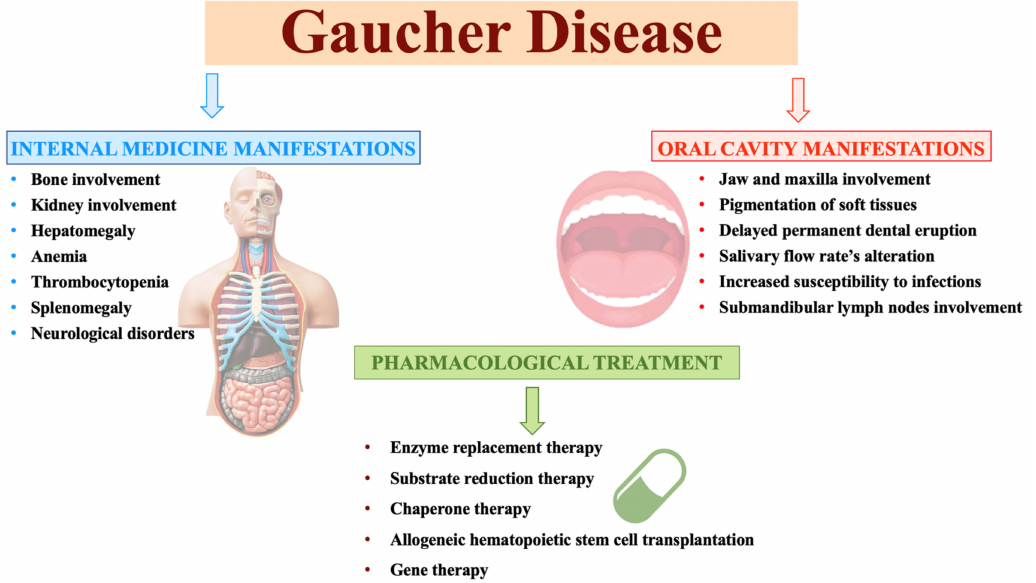
Figure 1. Gaucher disease manifestations in internal medicine and dentistry, including pharmacolog- ical